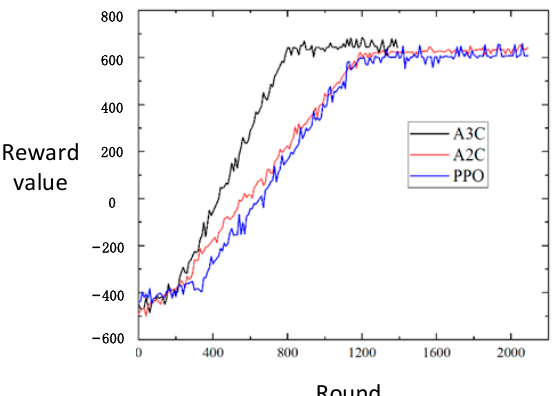
Figure 6. Algorithm comparison.